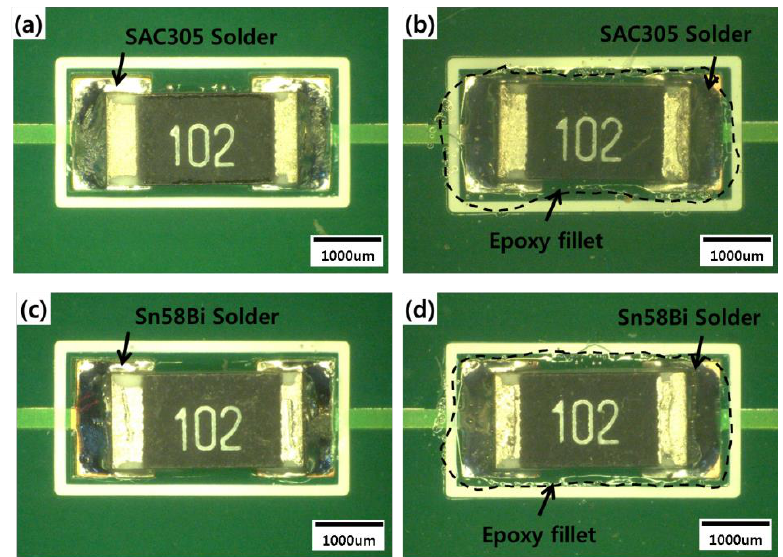
Figure 1. Top view of ( a ) an SAC305 solder joint, ( b ) an SAC305 epoxy solder joint, ( c ) an Sn58Bi solder joint, and ( d ) an Sn58Bi epoxy solder joint. joint, and ( d ) an Sn58Bi epoxy solder